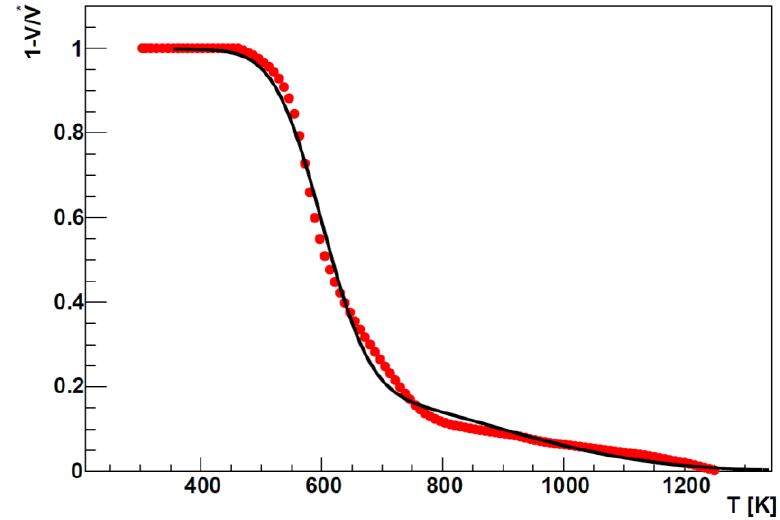
Figure 4. Comparison between the biomass experimental data (red points) and the 2-DAEM fitting (black line) data at 20 K·min −1 for the biomass.